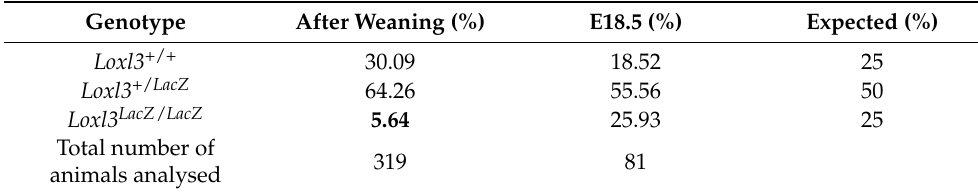
Table 1. Genotype frequency of the offspring from Loxl3 +/ LacZ heterozygous mice crossings. Value reflecting the perinatal embryonic lethality associated with Loxl3 LacZ / LacZ genotype is indicated in